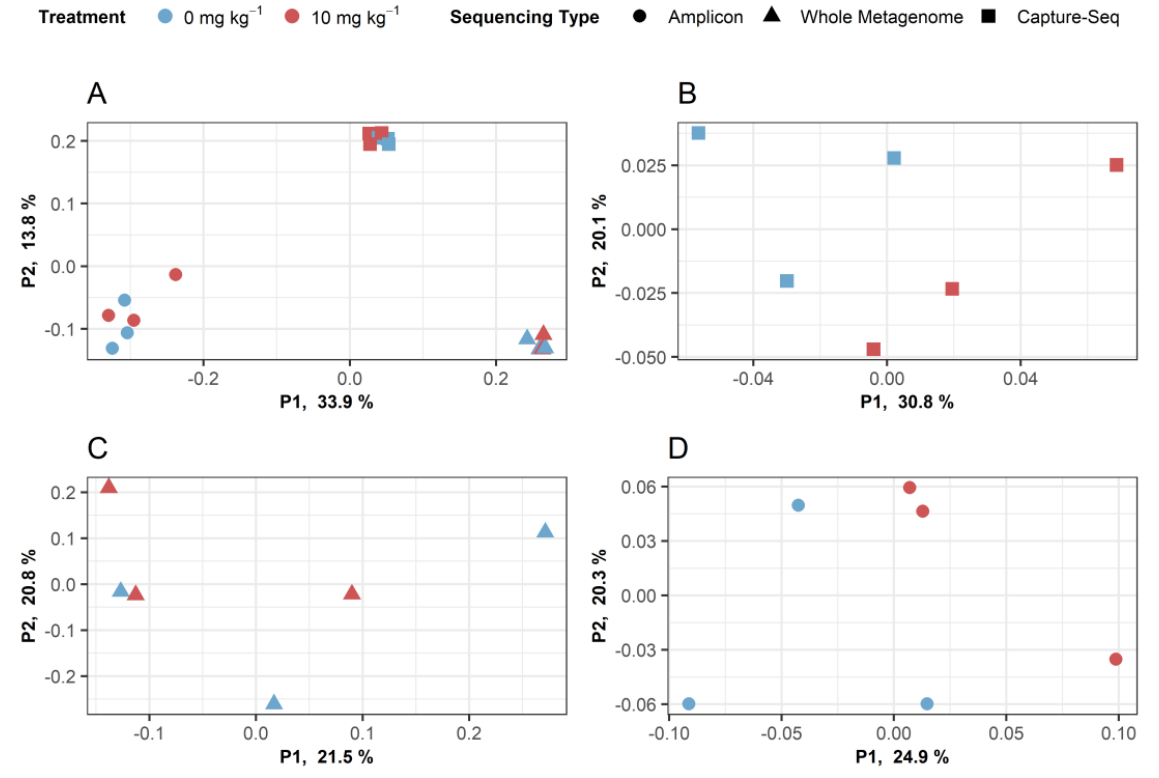
Figure 7. Principal coordinate analysis of Bray–Curtis dissimilarity between soil samples profiled using CaptureSeq (square), shotgun metagenomics (triangle), or cpn60 amplicon (circle) approaches. OTU frequencies were determined by reference mapping as described in the text. ( A ) All approaches considered together. ( B ) CaptureSeq. ( C ) Shotgun metagenomics. ( D ) cpn60 amplicon.